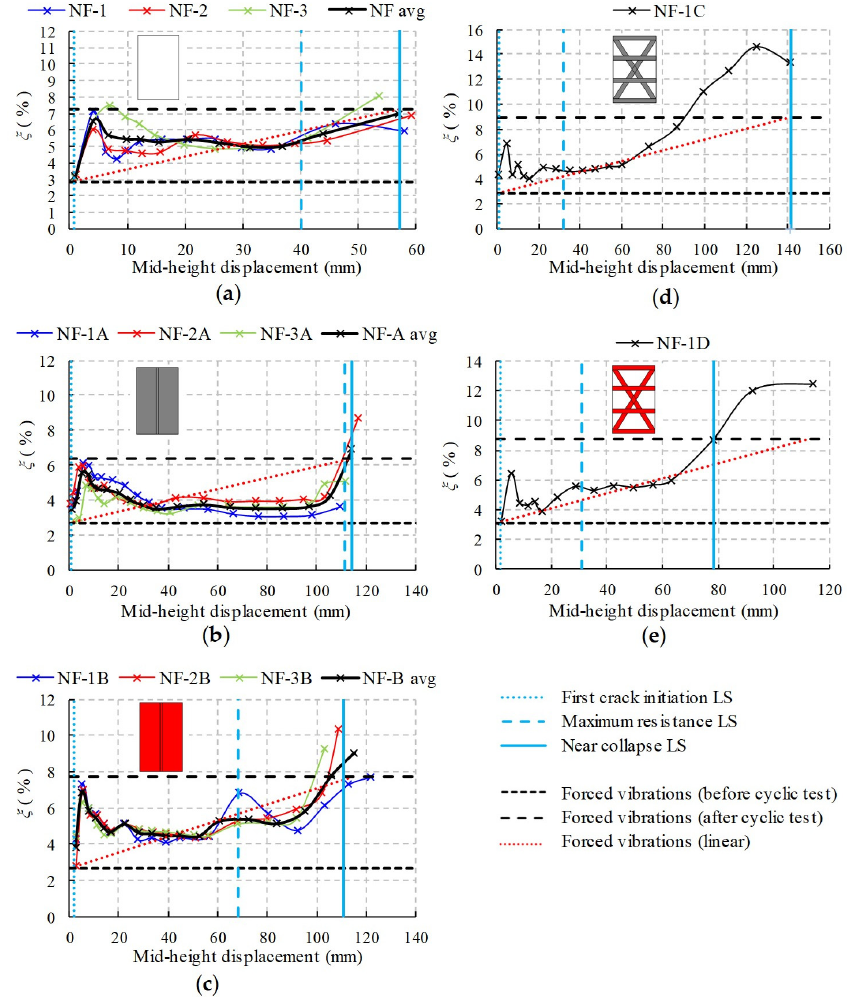
Figure 16. Development of equivalent viscous damping coefficients ξ H in comparison to the critical damping ratio ξ obtained from the dynamic forced vibration method: ( a ) Specimens NF-1, NF-2, and NF-3, ( b ) Specimens NF-1A, NF-2A, and NF-3A, ( c ) Specimens NF-1B, NF-2B, and NF-3B, ( d ) Specimen NF-1C, and ( e ) Specimen